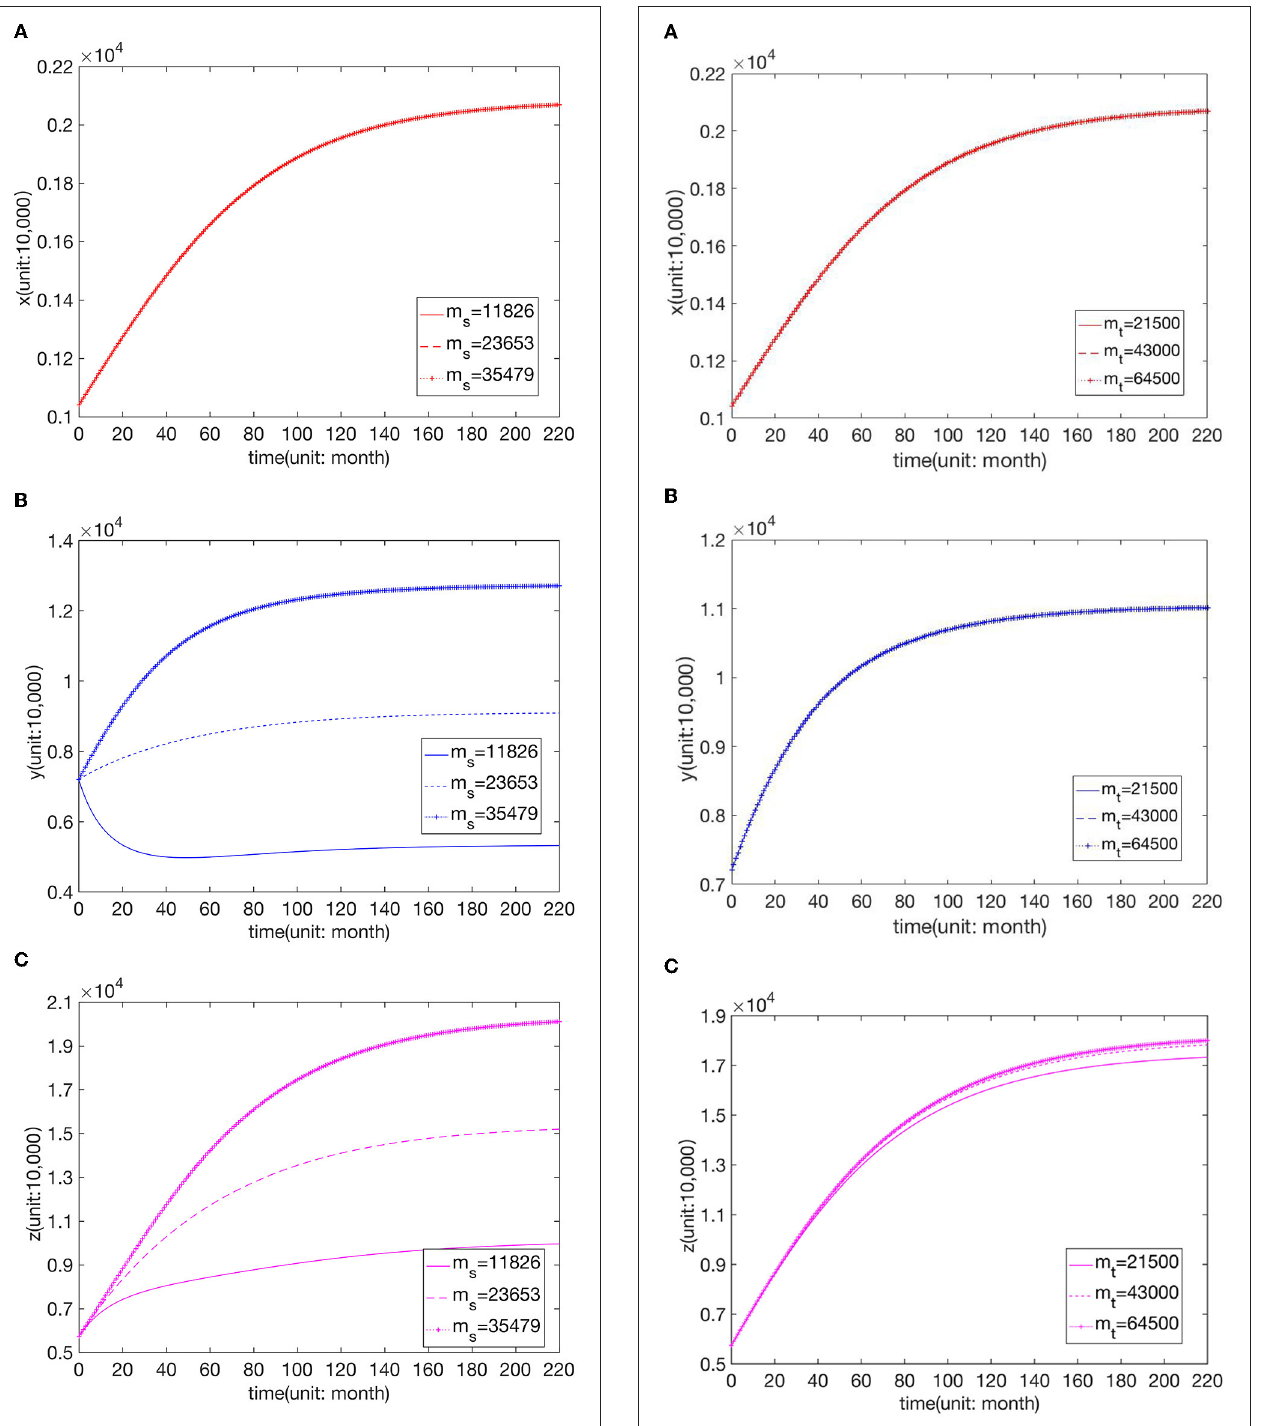
FIGURE 8 | Effect of parameter value m t on the number of visits to (A) FLHs, (B) SLHs, and (C) TLHs. We know that the increase in parameters m f , m s , and m t indicates that the comprehensive strength of the hospitals is improved, and thus the maximum capacity of patients